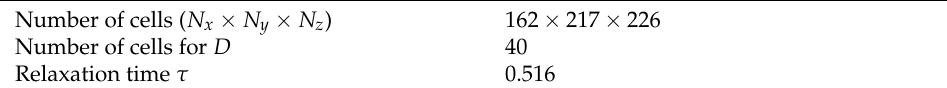
Table 4. Numerical conditions for flow in